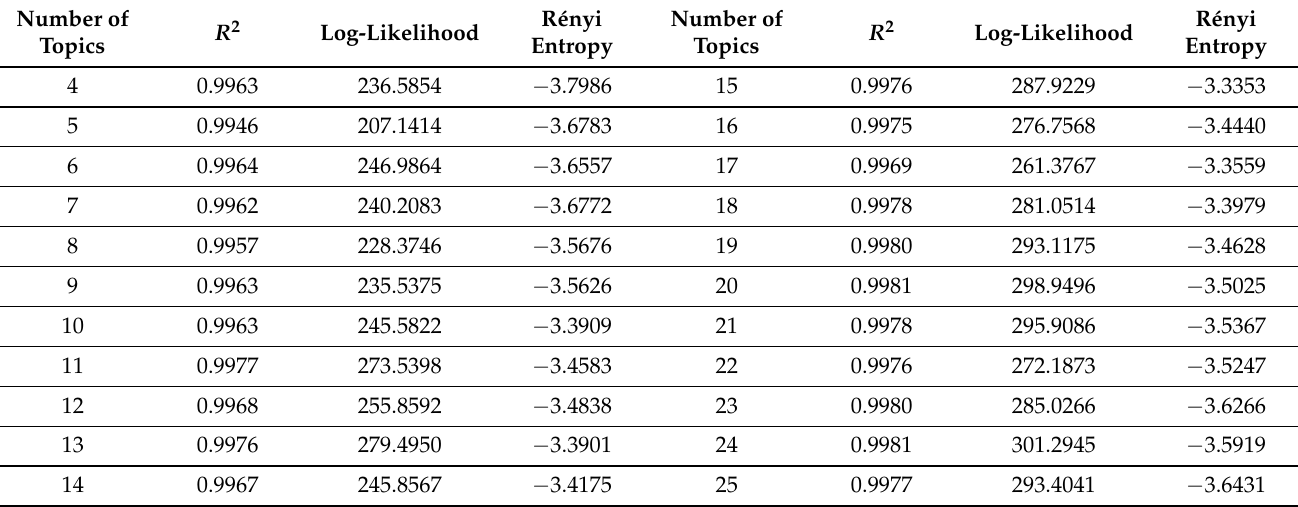
Figure 9. Evolution of Topic 6 proportions in SOTU speeches ( Topic Scaling ). Table 1. Results of Topic Scaling metrics, per different number of